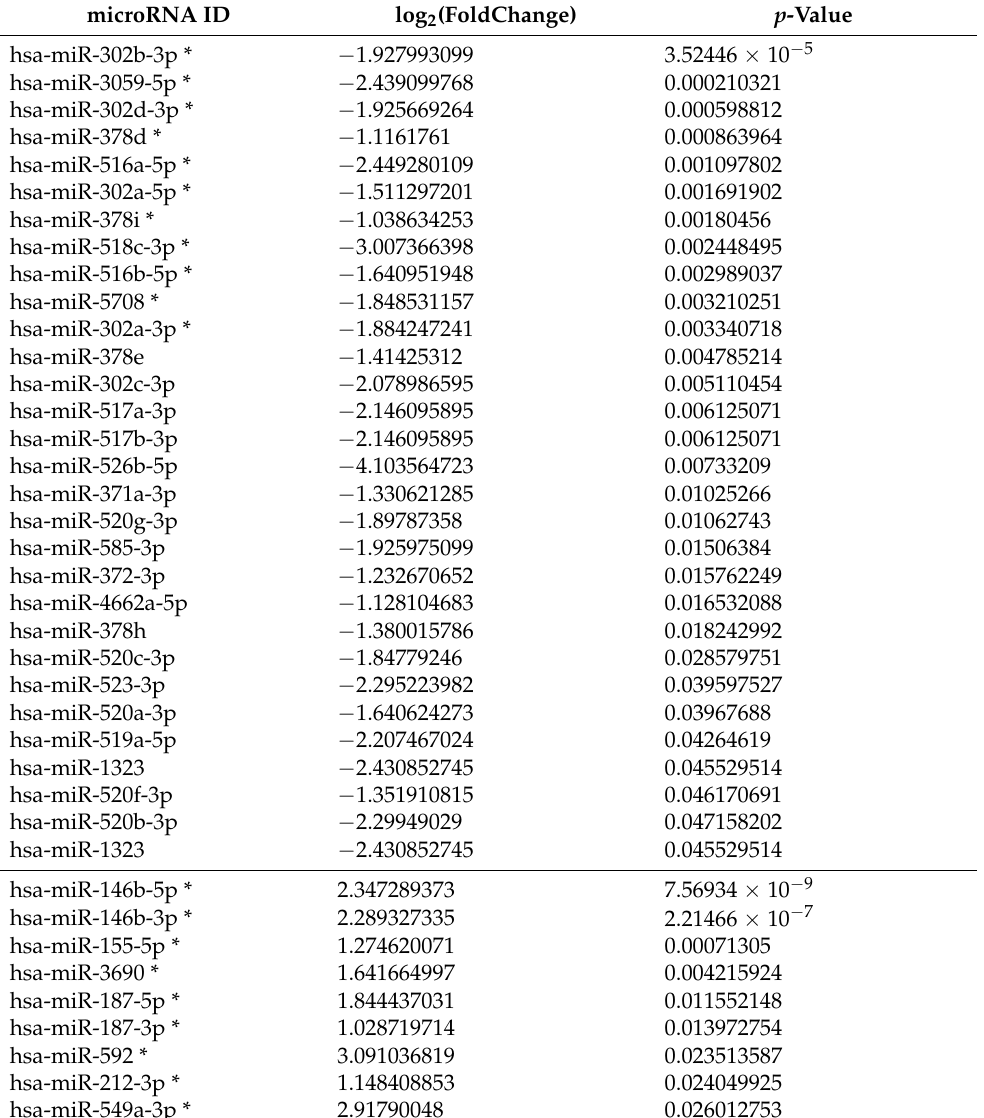
Table 2. Top deregulated